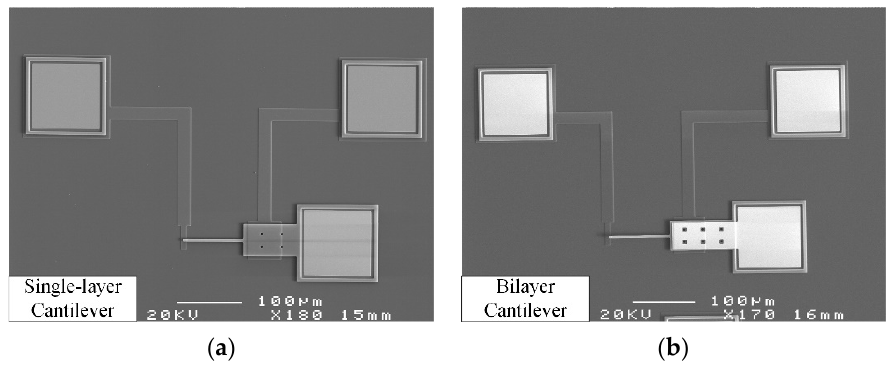
Figure 7. SEM photograph of the test structure: ( a ) test structure A; ( b ) test structure